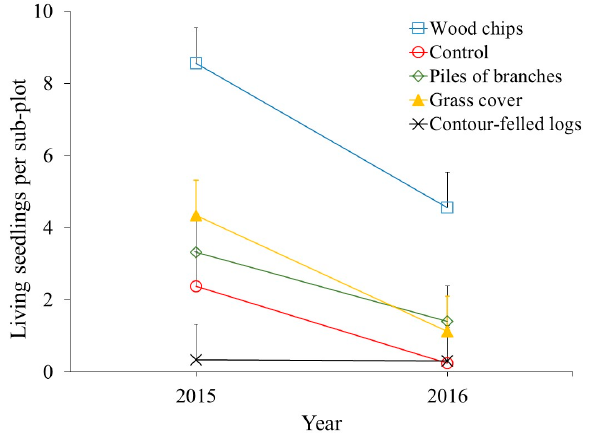
Figure 4. Interaction plot for the year × treatment factor. The means (±SE) of living seedlings per sub-plot after the summer (autumn 2015 and 2016) are represented in function of treatment (seeding method). Sample data = 160 sub-plots (50 × 50 cm). Total seeded sub-plots per treatment (seeding method) = 32. The results were similar analyzing seedling survival within the year (Table 3). The results in Figure 5 (using Fisher’s least significant difference LSD post hoc test; p < 0.05) show that a stronger response in seedling survival was observed in the seeding subjected to the wood chip cover (8.6 ± 1.3 living seedlings in 2015, and 4.6 ± 0.6 living seedlings in 2016), regardless of topographic aspect (pooled data). This treatment allowed more seedlings in the spot seeding to exist after summer than the control treatment (the seeding done on the bare ground; 2.4 ± 1.3 seedlings in 2015, and 0.2 ± 0.6